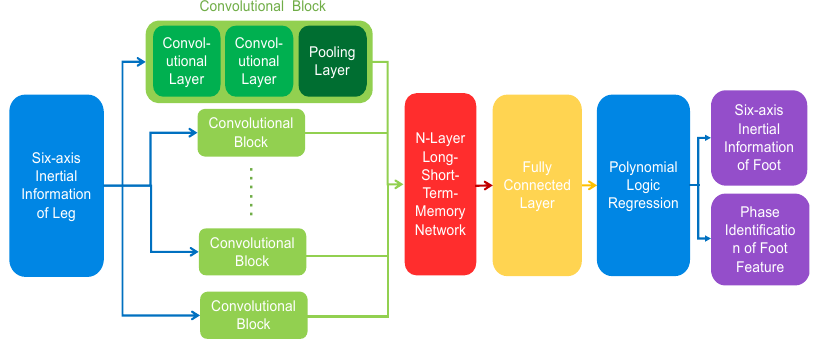
Figure 3. VGG-LSTM model architecture .